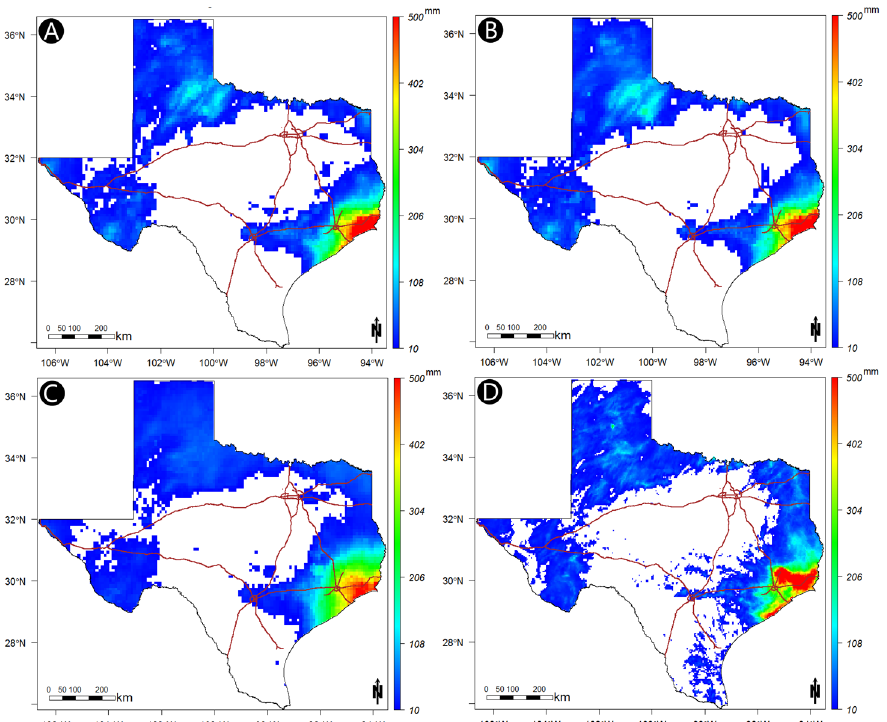
Figure 2. The spatial distribution of the cumulative precipitation estimation (≥10 mm) captured by IMERG ( A ) Early-, ( B ) Late-, ( C ) Final-run products, and ( D ) Stage-IV products during Tropical Storm Imelda from 14 to 21 September 2019.